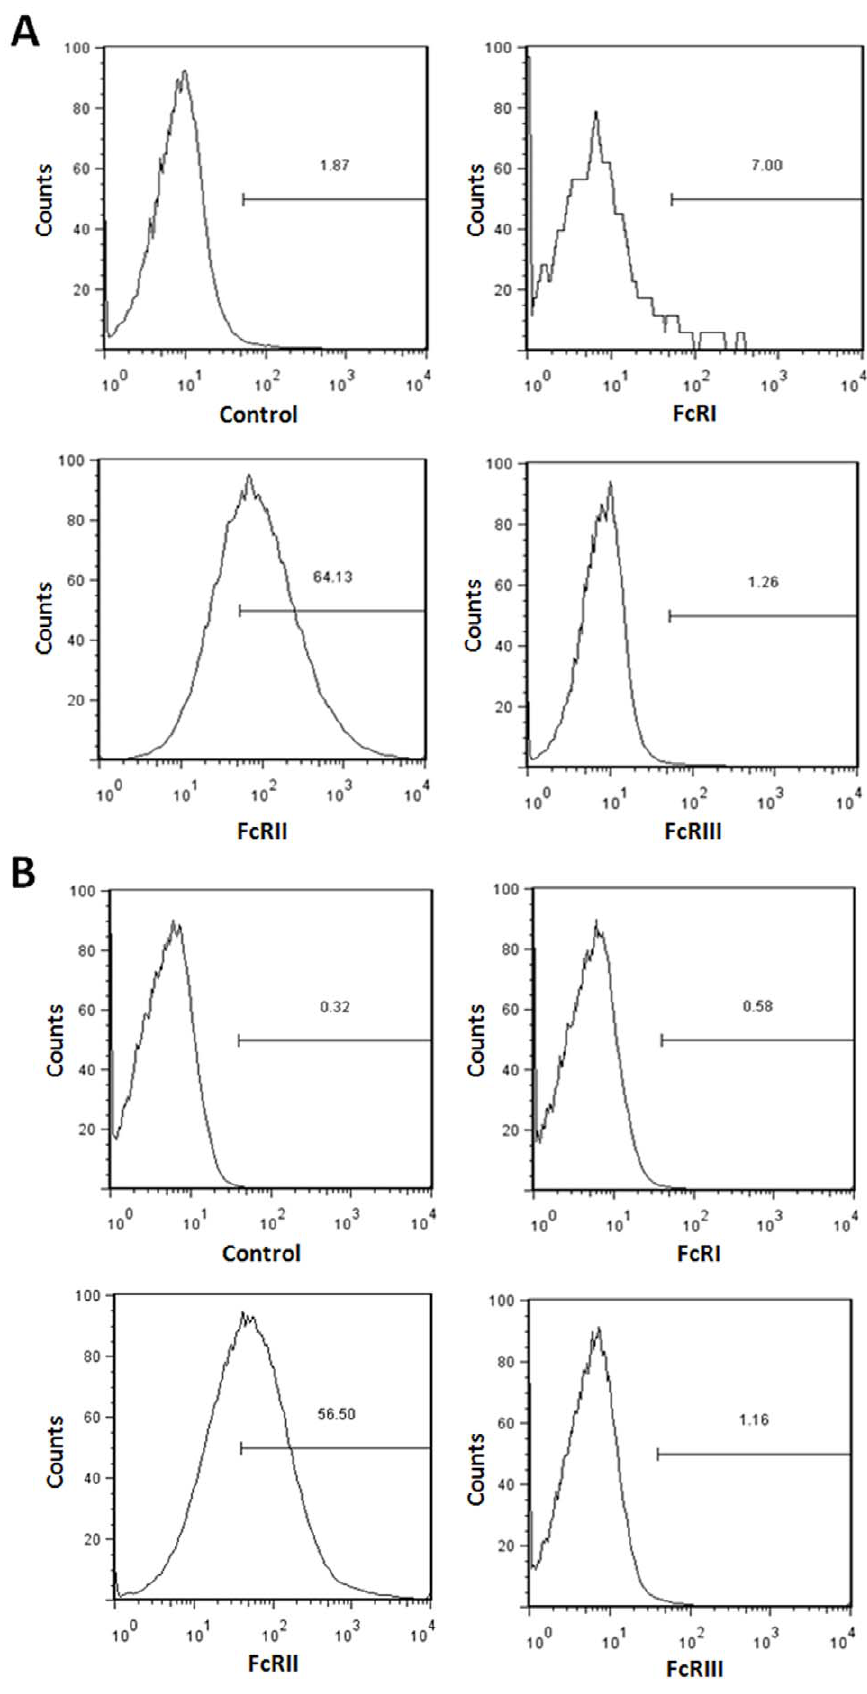
Figure 5. Fc receptor expression on hepatocyte surface. Hepatocytes were reacted with specific antibodies and the expression status of the three primary Fc receptors was analyzed by FACS. Results are shown for IHH (panel A) and Huh-7 (panel B). doi:10.1371/journal.pone.0023699.g005 PLoS ONE |